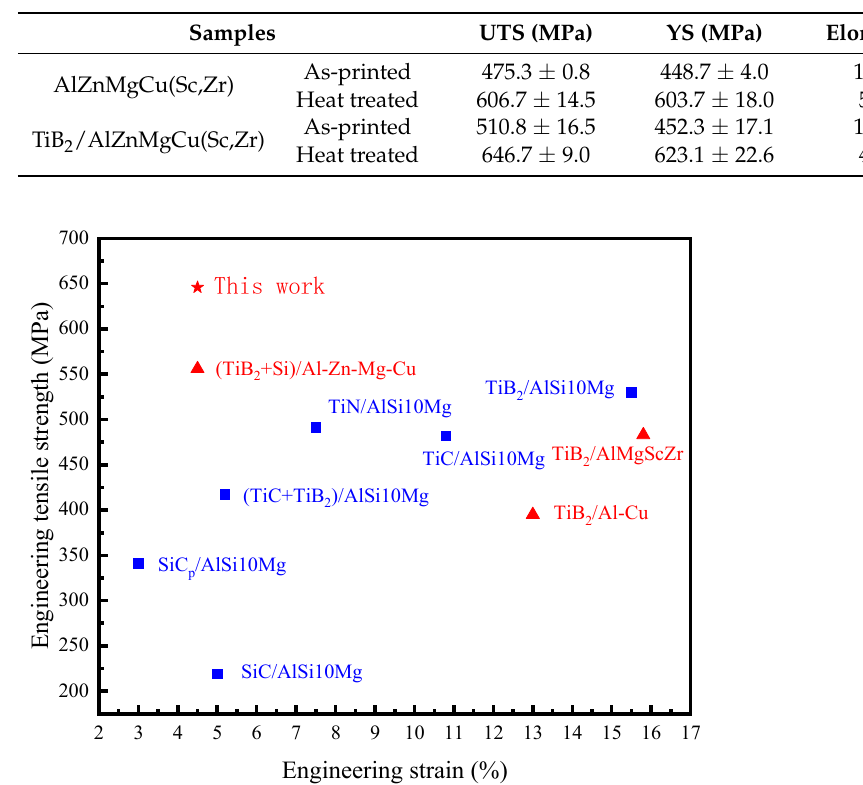
Figure 12. Comparison of mechanical properties of aluminum matrix composites formed by SLM [17,19,20,41,43–47].